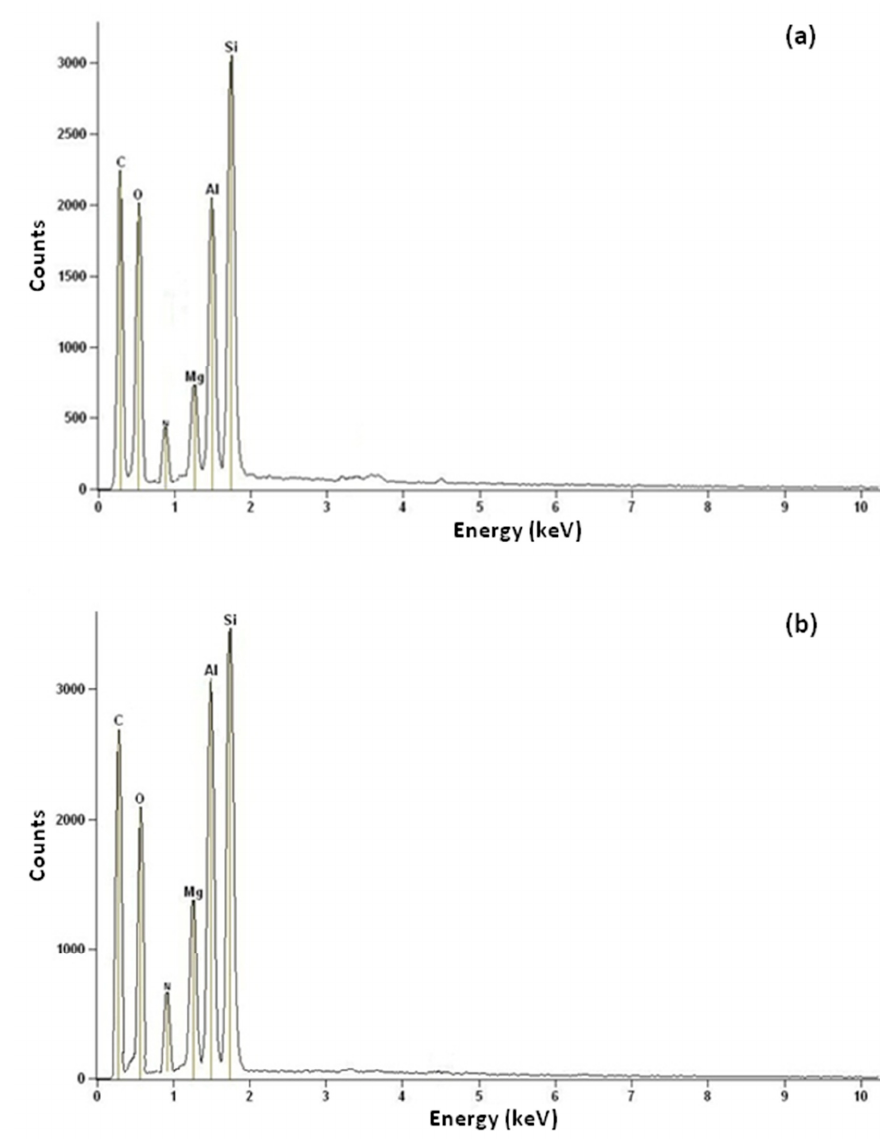
Figure 8. EDX analysis of ( a ) CNFCM and ( b ) modified CNFCM.